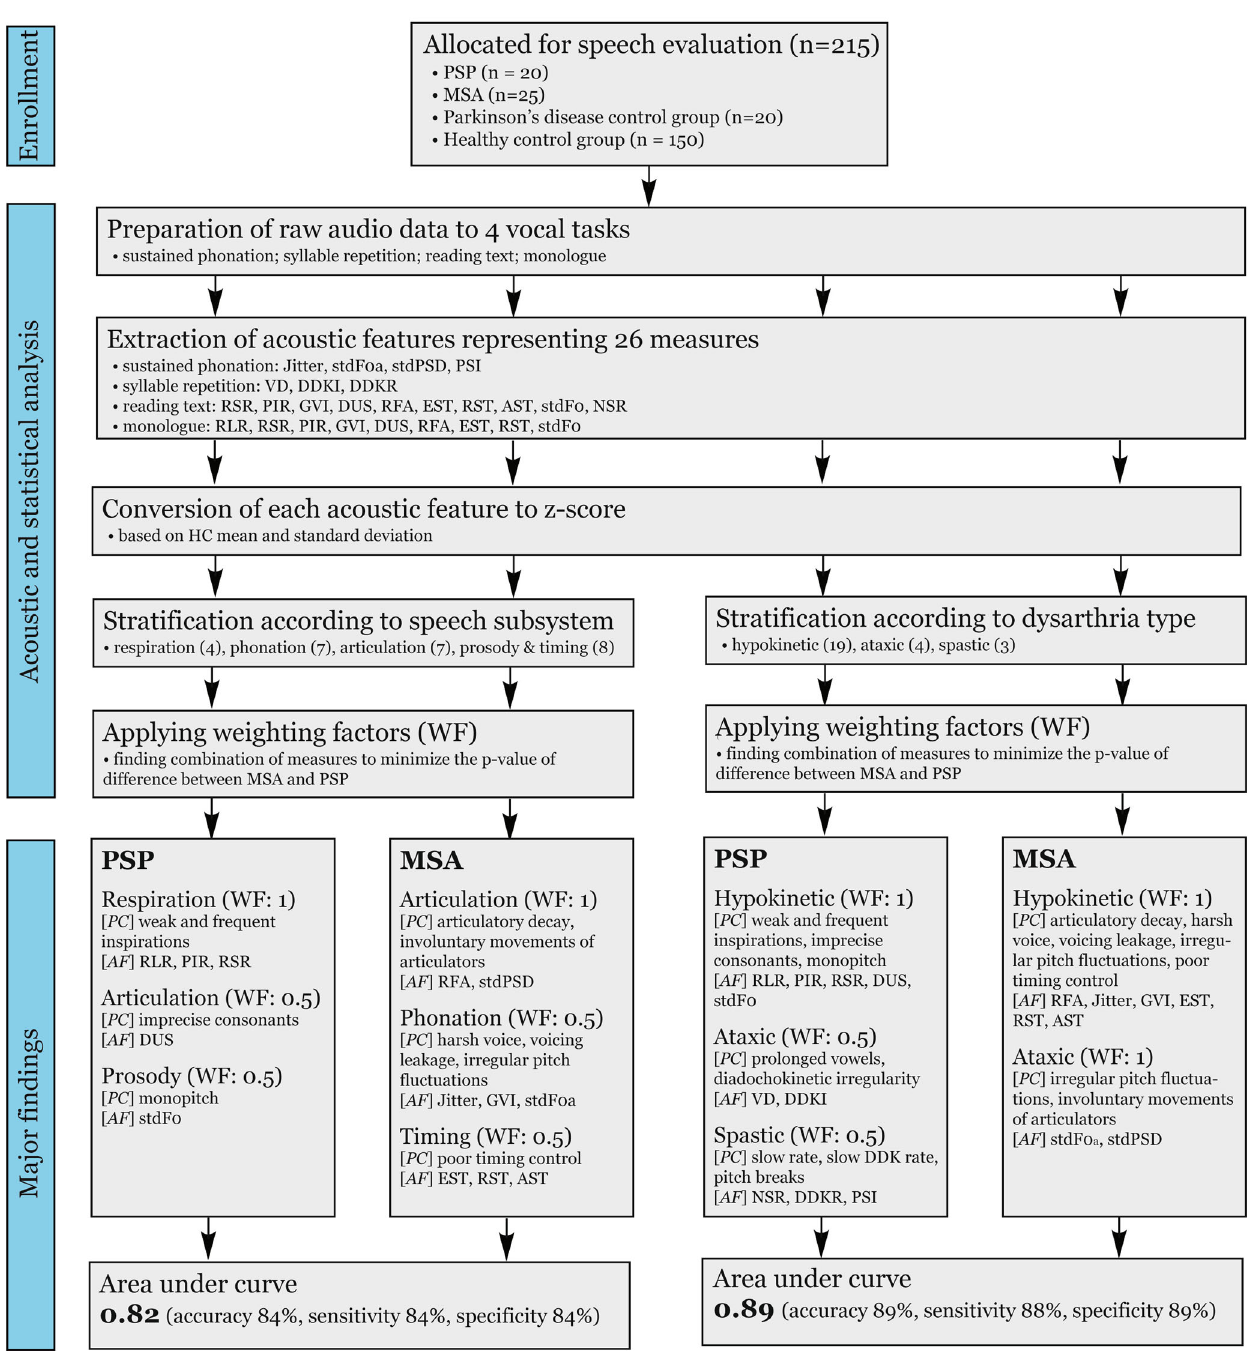
Fig. 1 Scheme chart depicting the methodology and major fi ndings. PC hypothesized perceptual correlates, AF acoustic features, WF weighting factor, RLR relative loudness of respiration, PIR pause intervals per respiration, RSR rate of speech respiration, DUS duration of stop consonants, stdF0 standard deviation of fundamental frequency, RFA resonant frequency attenuation, stdPSD standard deviation of the power spectral density, GVI gaping in-between voiced intervals, stdF0a pitch fl uctuations, EST entropy of speech timing, RST rate of speech timing, AST acceleration of speech timing, VD vowel duration, DDKI diadochokinetic instability, NSR net speech rate, DDKR diadochokinetic rate, PSI proportion of sub-harmonic intervals, PSP progressive supranuclear palsy, MSA multiple system